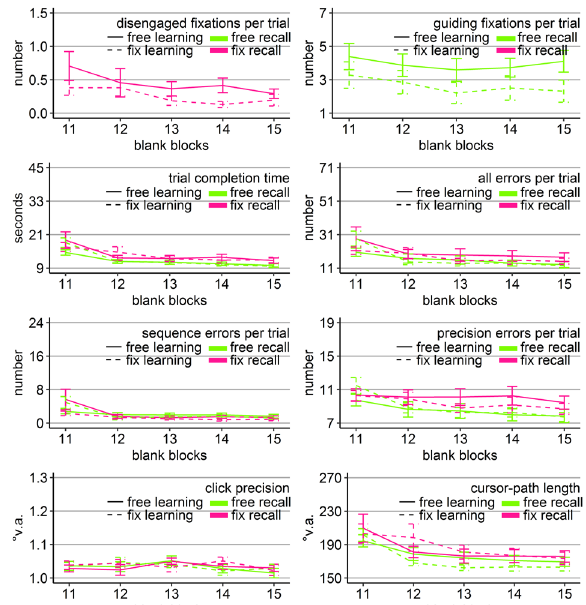
Figure 9. Gaze and performance measures during the recall phase of Experiment 4. The top left plot shows how often participants who were asked to keep central fixation, disengaged their fixation per trial (y-axis) over the course of the five blank blocks (x-axis) depending on whether they learned the clicking sequence with free gaze (solid line) or with fixed gaze (dashed line). The top right plot shows how many guiding fixations participants who were allowed to move their eyes freely, performed per trial (y-axis) during the five blank blocks (x-axis) depending on whether they had learned the clicking sequence with free gaze (solid line) or with fixed gaze (dashed line). The six bottom plots show the six performance measures trial completion time in seconds, numbers of all errors, sequence errors, and precision errors per trial, click precision in °v.a., and cursor-path length in °v.a. (y-axes) over the course of the five blank blocks (x-axes) for the four group combinations of recall with free gaze (green lines) or fix gaze (pink lines) after learning with free gaze (solid lines) or fix gaze (dashed lines). Error bars represent standard errors of the